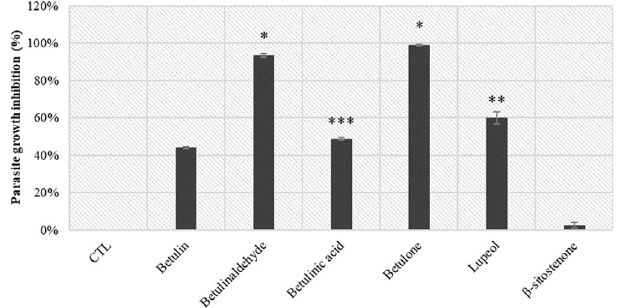
Figure 2. Screening at 10 l M of isolated compounds ( 1 – 5 , 9 ) from n -heptane bark extract of A. glutinosa